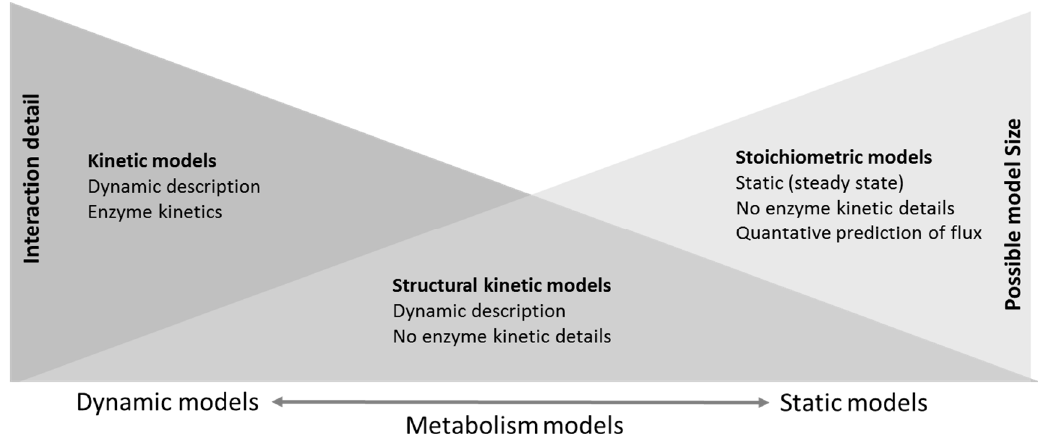
Figure 2. Schematic comparison of representative methods for the metabolic pathway and network models including different constraints and approaches to defining metabolic reactions.